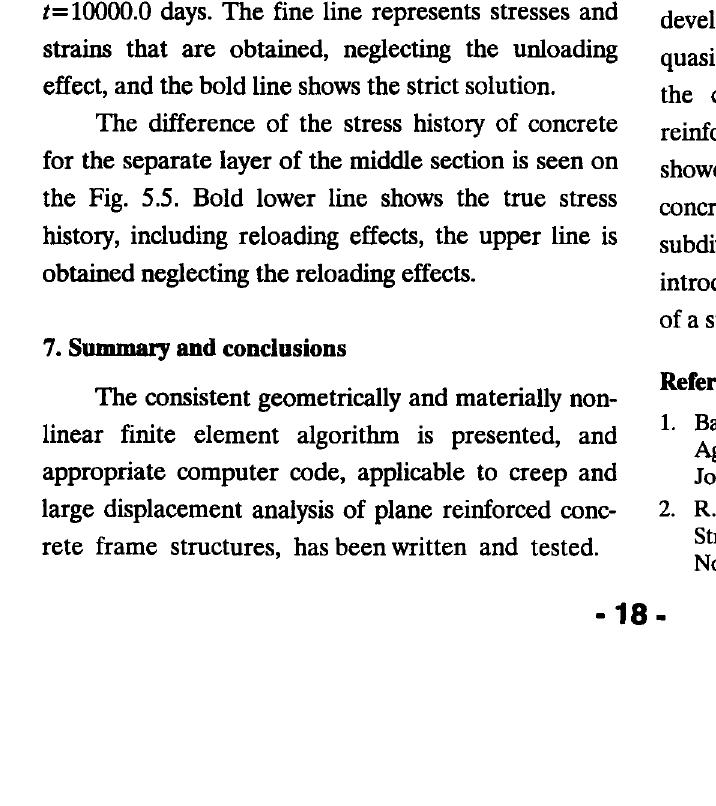
Fig. 5.5. Stress history for the layer y= -0.0325 m of the middle cross-section of the